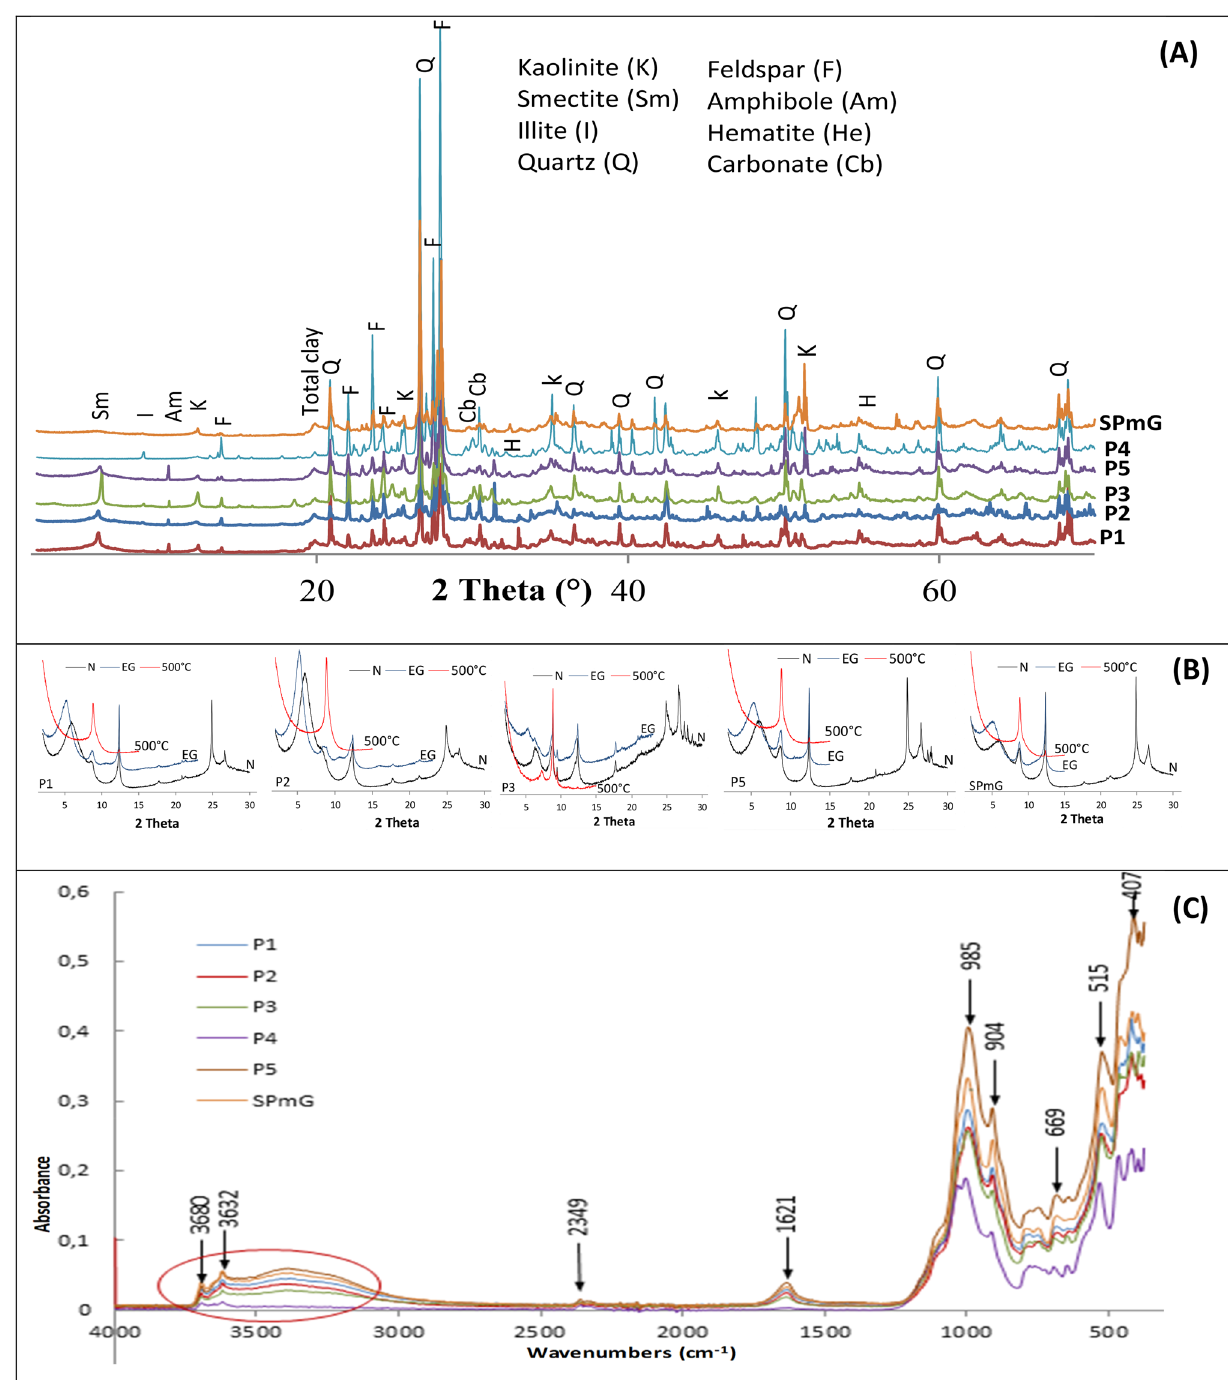
Fig. 4 XRD patterns of samples a Bulk XRD pattern; K: kaolinite, Q: Quartz; Felds: Feldspar. b Clay < 2 μm pattern; N: air dried condition; EG glycolated condition with ethylene glycol for 22 h; H: heated at condition (500 °C for 4 h). c FTIR curves of clays